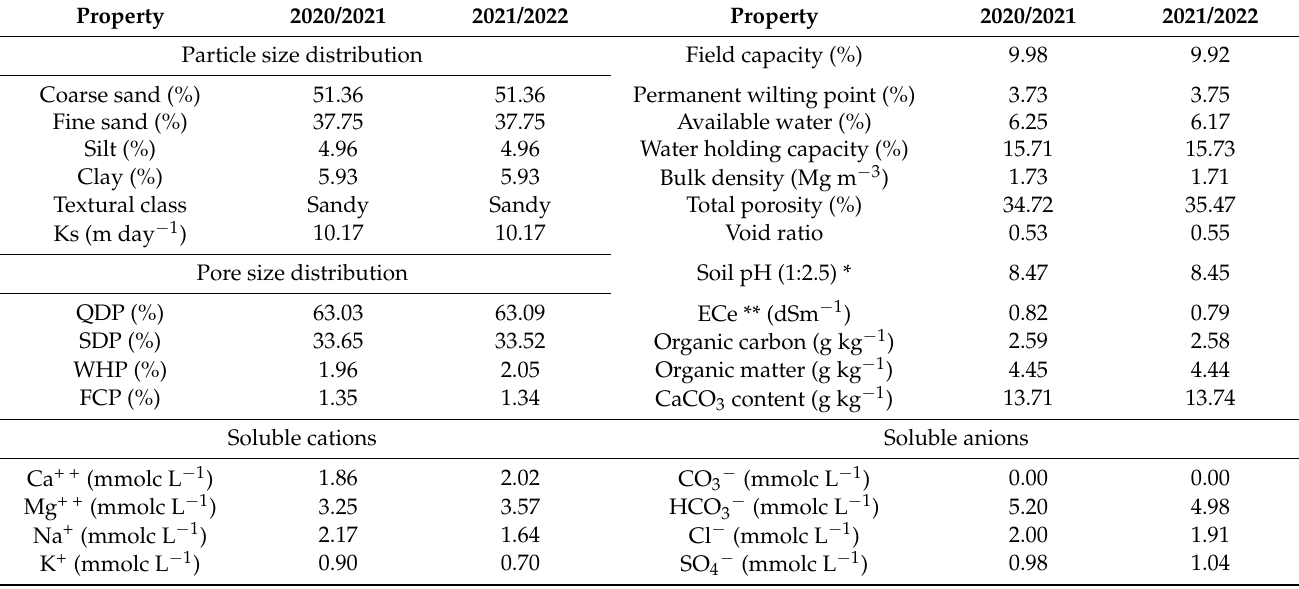
Table 2. Some physical and chemical properties of the experiment soil at sowing in both 2020/2021 and 2021/2022 winter growing seasons.